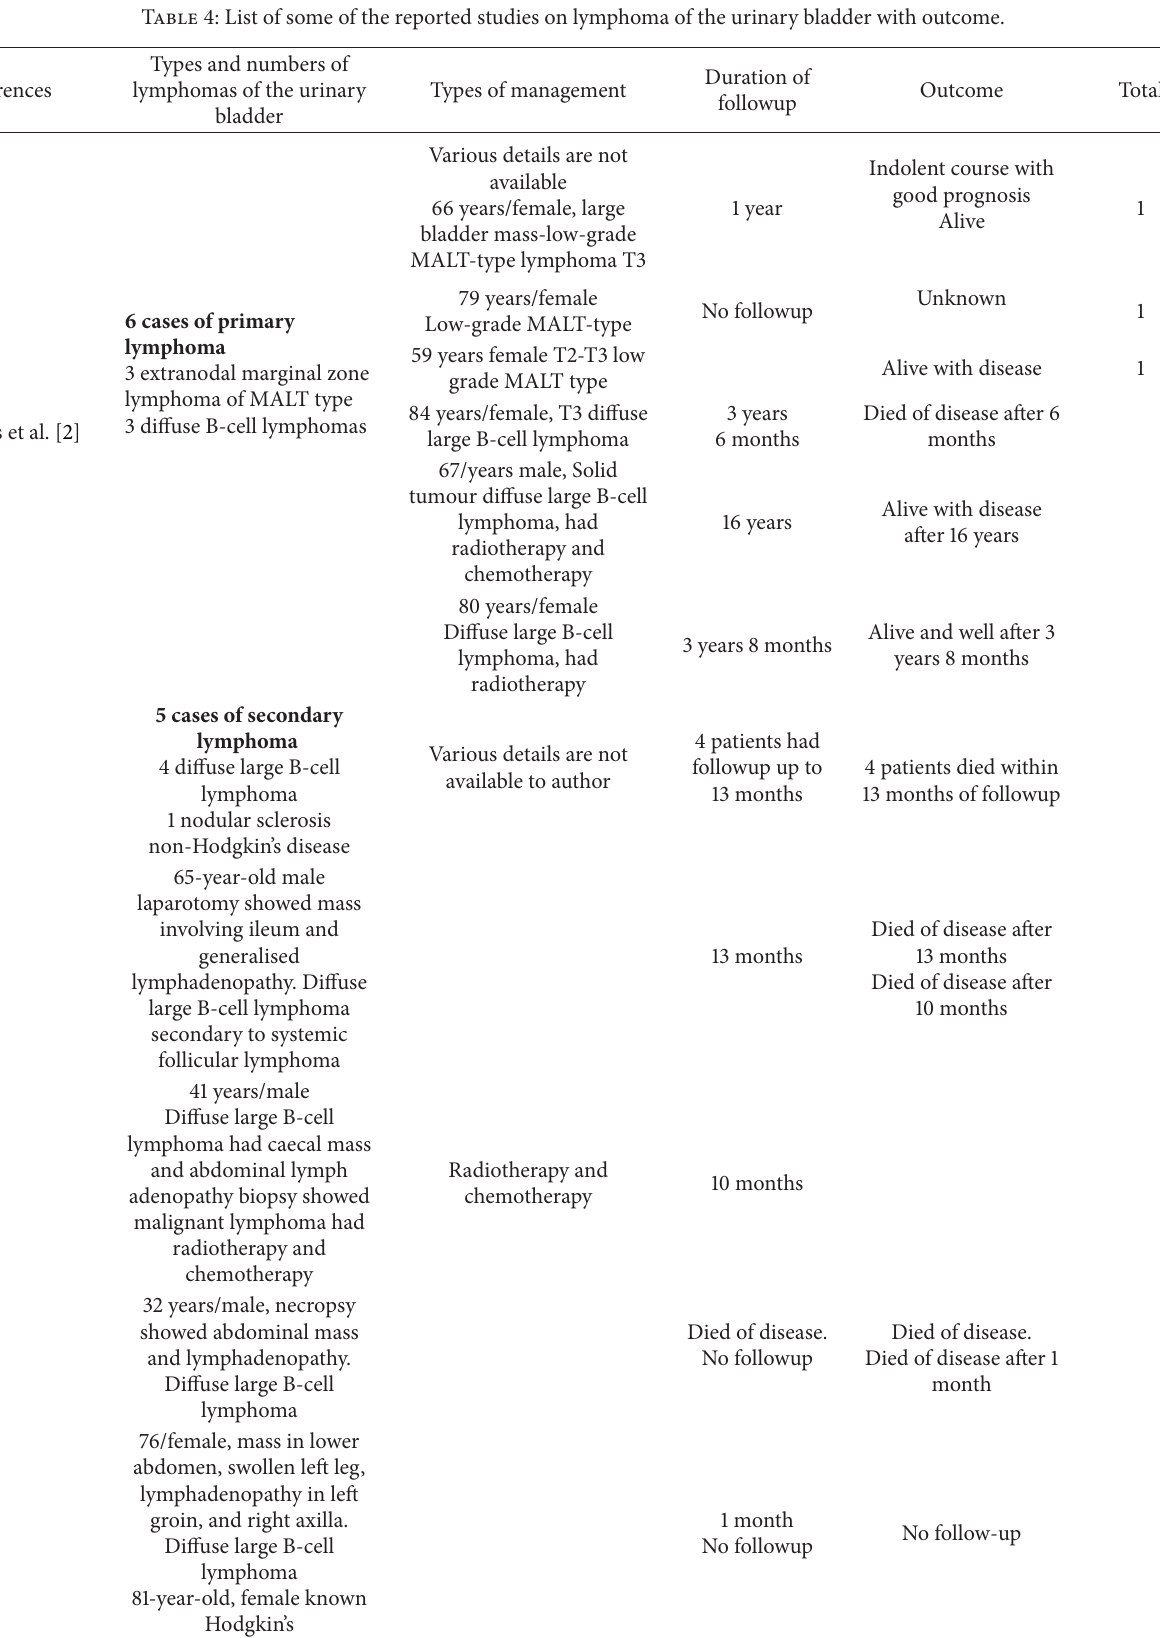
Table 4: List of some of the reported studies on lymphoma of the urinary bladder with